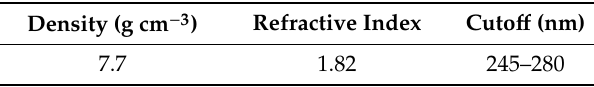
Figure 1. Paired Cherenkov detectors and 125 training source positions. Two Cherenkov detectors were placed face-to-face, 50 mm apart. The origin of the coordinate system, ( x , y , z ) = (0, 0, 0), was defined at the center of the detector plane for ( x , y ) and at the center between the pair of the detectors at the z -axis. A monolithic PbF 2 crystal with a 40 × 40 × 10 mm 3 Cherenkov radiator was coupled to a photodetector array through 300- μ m-thick protection resin ( n = 1.5) with grease ( n = 1.5). Table 1. Optical properties of PbF 2 crystal.